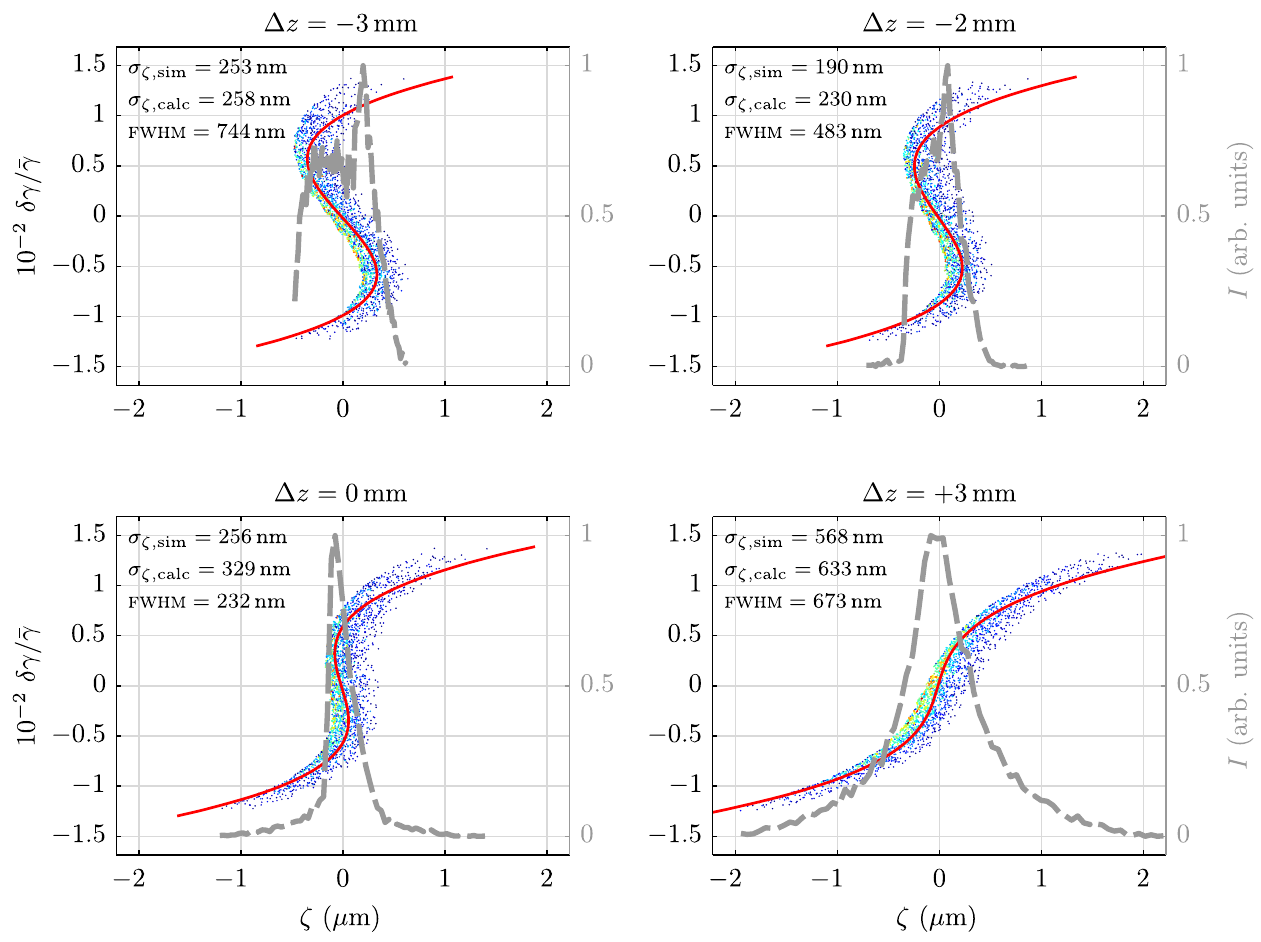
FIG. 7. Comparison of the longitudinal phase space of case (i) at four different positions around the shortest bunch length. For both 1 ps is launched. The analytic calculation, depicted versions, an inverted parabolic density distribution with an emission time of τ RMS ¼ by the red line, resembles the tracked distribution (without space charge) to a very good degree — despite the thin lens approximation of the buncher description. The gray dashed line depicts the current profile of the distribution, determined by the local particle density of the A STRA simulation results. At Δ z ¼ 0 mm, the slope is (almost) infinite, which resembles the focus definition of the analytical model: all particles have the same longitudinal position at the same time (up to the second order). At this position, the FWHM width — evaluated from the current profile — is minimal. The minimal RMS bunch length is reached at ( Δ z ¼ − 2 mm), since the third order present is partly compensated by a negative slope.